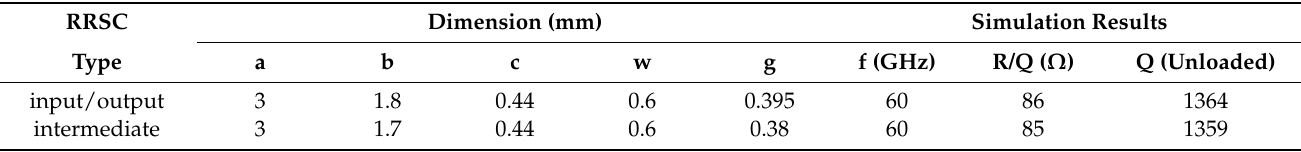
Table 1. Dimensions of RRSCs and simulation